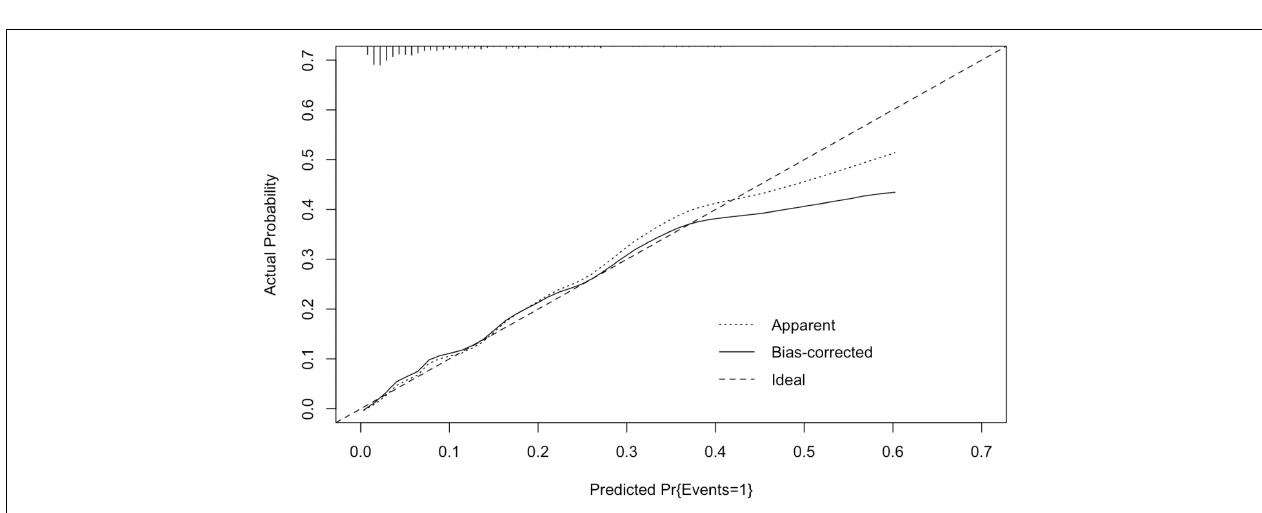
FIGURE 3 | Nomogram model for predicting CPET-related cardiovascular events in patients with CHD after PCI. The first line was the points of risk factors, and the second to sixth lines were risk factors. By summarizing each risk factor point, total points could be obtained. Then, the event probability (line 8) was calculated according to the total points of line 7. HbA1c, glycosylated hemoglobin A1c; Sm, systolic velocity of mitral annulus; VE/VCO 2 slope > 30, minute ventilation/carbon dioxide output slope > 30; (cid:49) VO 2 / (cid:49) WR slope inflection, inflection of oxygen uptake relative to work rate; Events, CPET-related cardiovascular events.